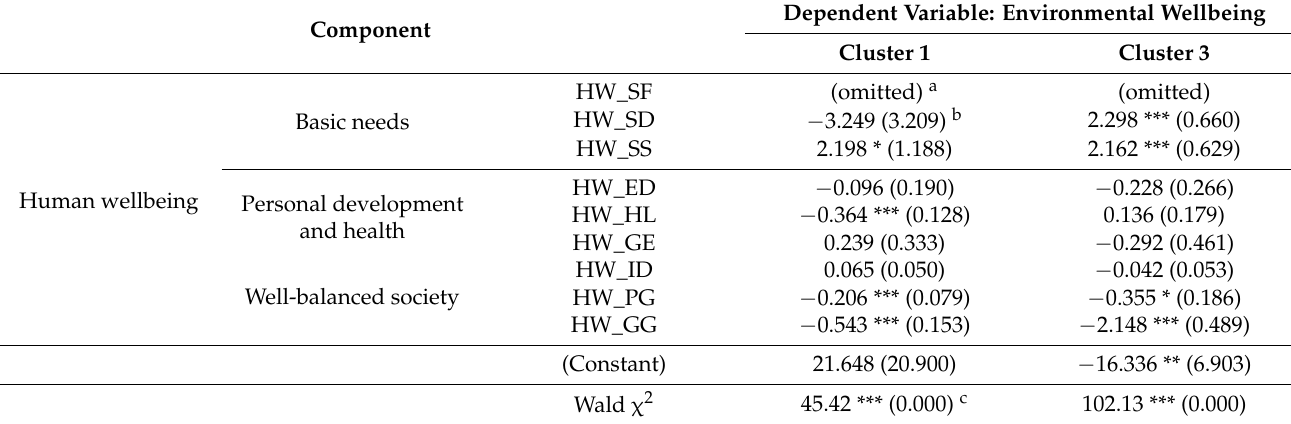
Table 5. Relation between environmental wellbeing and the components of human wellbeing in clusters 1 and 3.